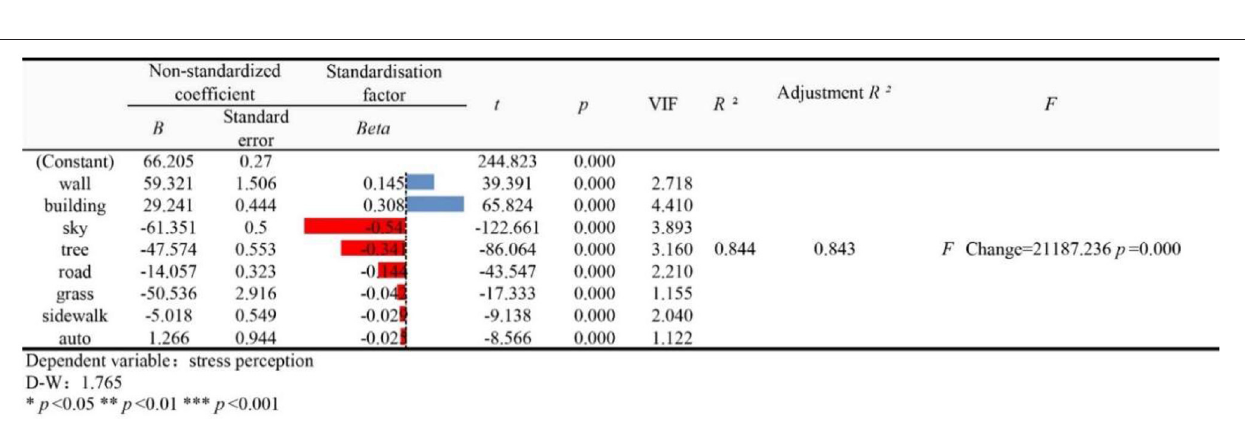
FIGURE 13 | Representative images for different levels of perceived stress. The hexagon represents the eight image segmentation elements, clockwise from the vertex: (1) walls, (2) buildings, (3) the sky, (4) vegetation, (5) roads, (6) grass, (7) sidewalks, and (8) auto.